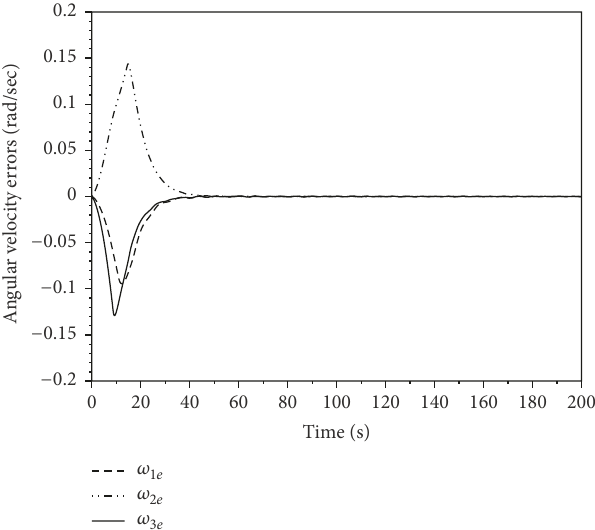
Figure 10: Angular velocity errors under controller